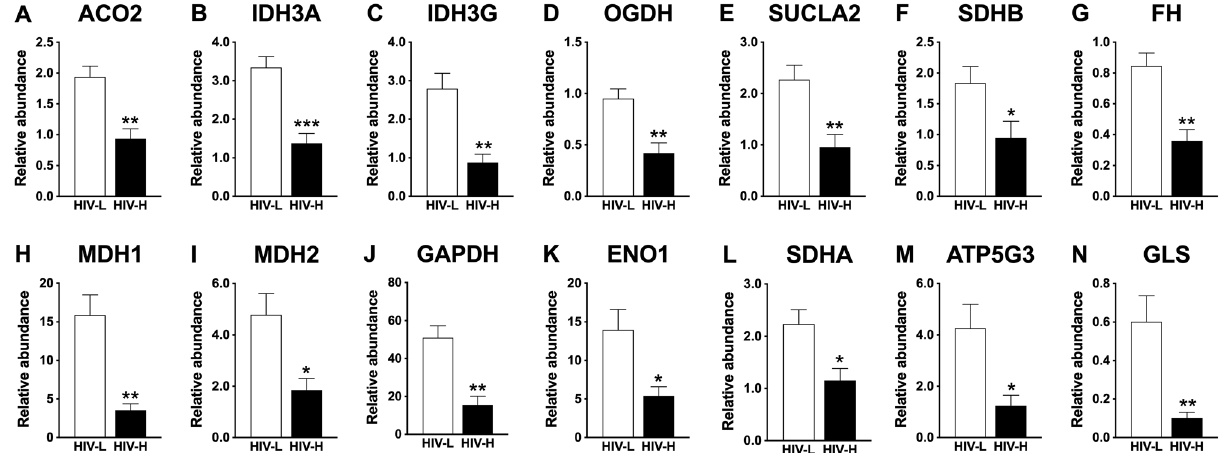
Figure 3. Dysregulation of the expression of genes related to energy metabolism and the tricarboxylic acid (TCA) cycle in patients with high brain HIV RNA load. The mRNA levels of genes related to energy metabolism and the TCA cycle were compared in an independent sample of frontal cortices of patients with low brain HIV RNA load (HIV L) and high brain HIV RNA load (HIV H) by RT-PCR (n = 5). Reduced levels were observed for the mRNAs of mitochondrial TCA cycle enzymes, including ( A ) aconitase 2 (ACO2), ( B ) isocitrate dehydrogenase subunits α (IDH3A) and ( C ) γ (IDH3G), ( D ) α-ketoglutarate dehydrogenase (2-oxoglutarate dehydrogenase E1 component, OGDH), ( E ) succinyl-CoA ligase subunit β (SUCLA2), ( F ) succinate dehydrogenase (SDHB) subunit β, ( G ) fumarate hydratase (FH), and ( H ) malate dehydrogenase 1 (MDH1) and 2 (MDH2) (I) as well as for the glycolytic enzymes ( J ) glyceraldehyde 3-phosphate dehydrogenase (GAPDH) and ( K ) α-enolase (enolase 1 [ENO1]) and mitochondrial respiratory chain proteins ( L ) succinate